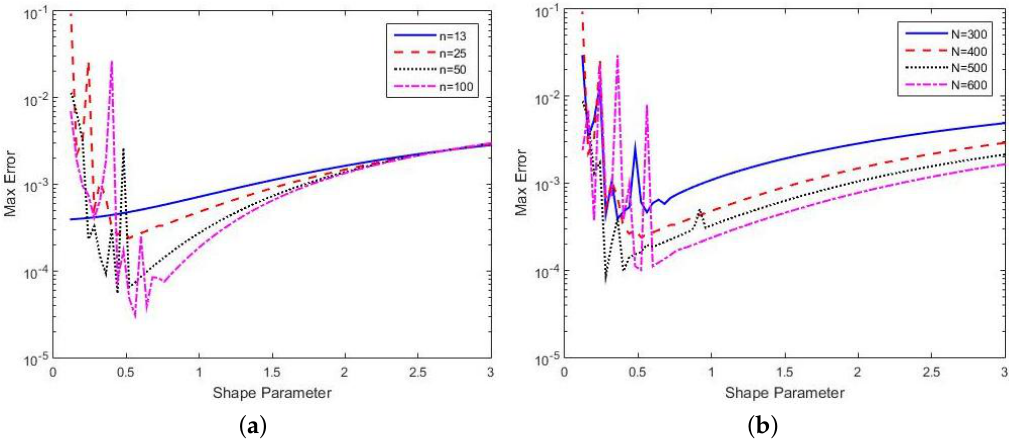
Figure 3. The graph of the max error of the RBF-FD method with different numbers of nodes and stencils. ( a ) varying number of stencils (n); ( b ) varying number of nodes